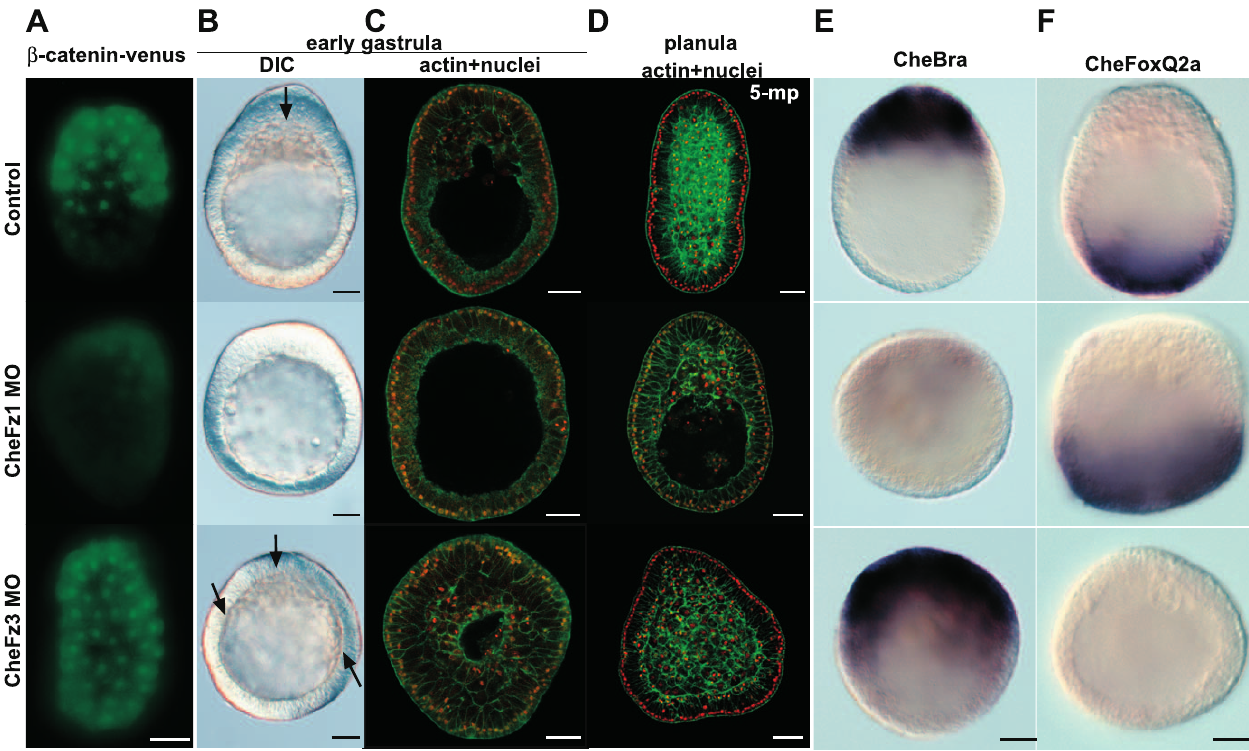
Figure 3. CheFz1 and CheFz3 Regulate the Canonical Wnt Pathway and Direct Oral and Aboral-Specific Gene Expression (A) Activation of the canonical Wnt pathway in mid-blastula–stage control embryos (top row) and embryos derived from CheFz1-Mo (middle row)– or CheFz3-Mo (bottom row)–injected eggs, visualised by injecting eggs prior to fertilisation with RNA coding for a b -catenin–Venus fusion protein. Coinjected rhodamine dextran was distributed uniformly (not shown). b -catenin–Venus was stabilised specifically in the oral half of control embryos. CheFz1-Mo reduced b -catenin–Venus to barely detectable levels, while CheFz3-Mo caused it to accumulate in all cells. (B) Characteristic phenotypes of embryos derived from CheFz1-Mo– or CheFz3-Mo–injected eggs compared with uninjected controls. Differential interference contrast images of early gastrula-stage embryos: arrows indicate ingressing cells. CheFz1-Mo severely reduced the extent of cell ingression, although did not prevent oral thickening of the epidermal layer, while CheFz3-Mo caused expansion of the zone of cell ingression across most of the embryo. (C) Confocal images of similar early gastrula-stage embryos, with cell contours visualised using fluorescent phalloidin (green) and nuclei with ToPro3 (red). (D) Equivalent images of planula-stage embryos (1 d after fertilisation). There is a clear deficit in endoderm formation in embryos of CheFz1-Mo–injected but not in control CheFz1-5mp-Mo–injected embryos. CheFz3-Mo embryos show both endoderm and ectoderm, but oral–aboral polarity is disrupted. (E) Representative in situ hybridisation images of early gastrula embryos showing abolition of the oral CheBra expression territory following CheFz1-Mo injection, and expansion following CheFz3-Mo injection. (F) Aboral CheFoxQ2a expression at the same stage was abolished following CheFz3-Mo injection but expanded following CheFz3-Mo injection. In all panels, embryos are oriented with the oral pole up. Bars ¼ 40 l